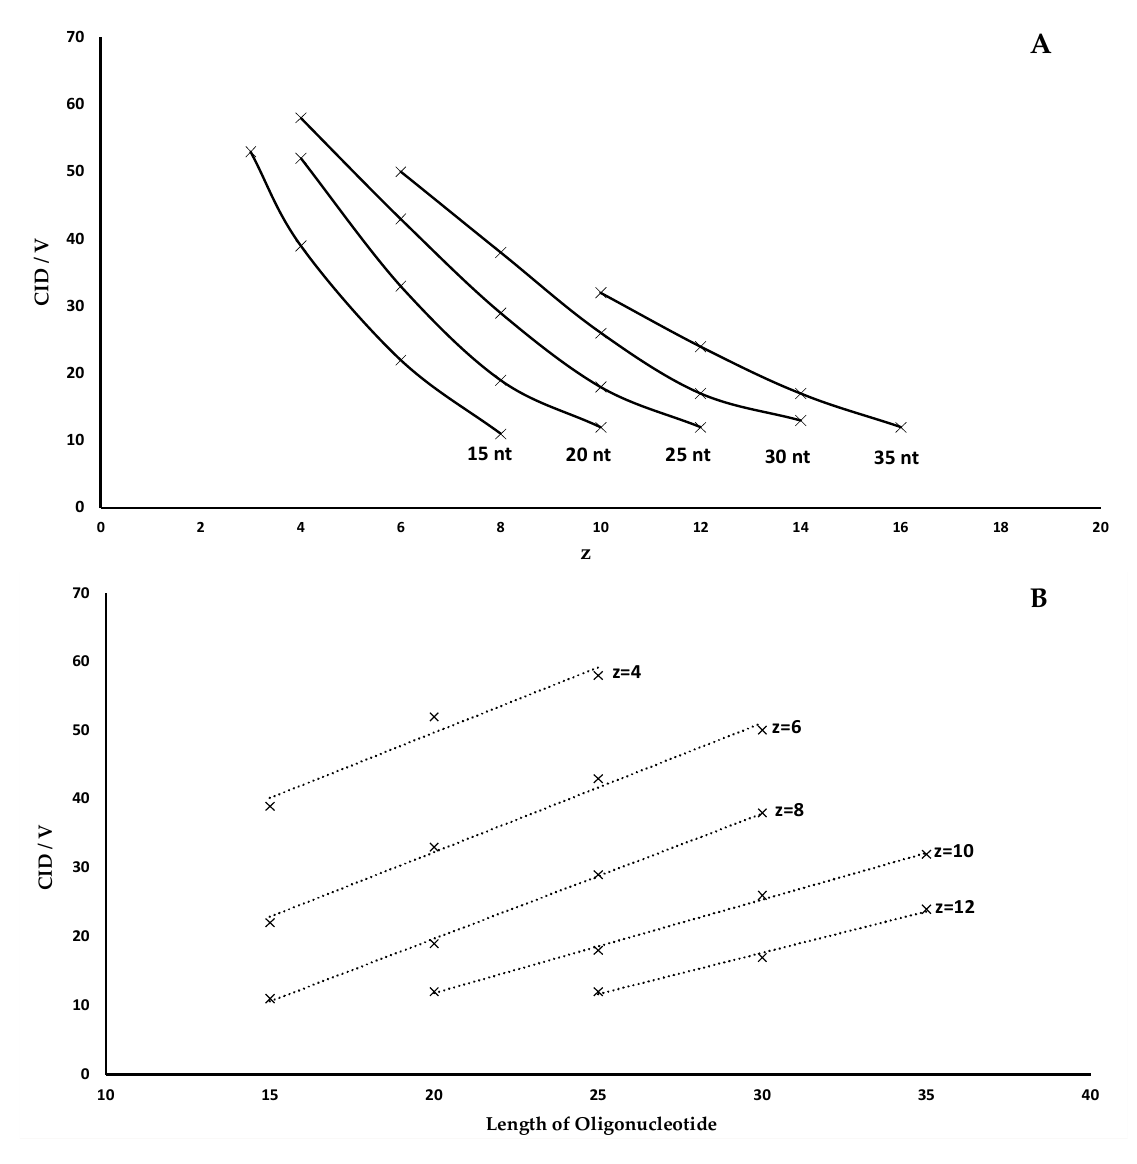
Figure 2. ( A ) Correlation of CID voltage and charged state. ( B ) Correlation of length to CID voltage at similar charged states.